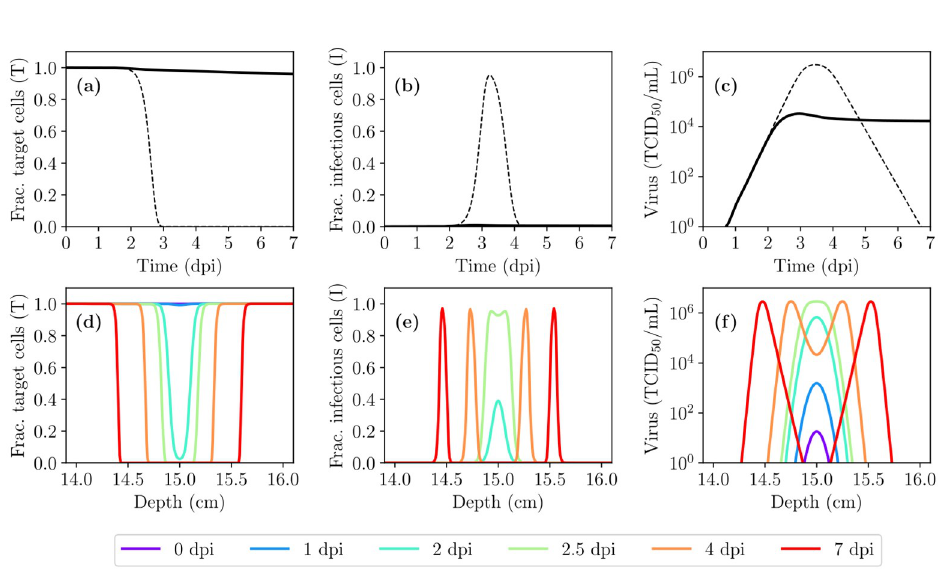
Fig 2. IAV infection kinetics in the presence of diffusion alone (no advection). (Top) Time course (averaged over space) of the infection for the fraction of cells in the (a) target/uninfected or (b) infectious state, and (c) the infectious virus concentration, obtained using the non-spatial ODE MM (dashed) or the spatial (diffusion only) MM (solid). (Bottom) Localized fraction of cells in the (d) target or (e) infectious state and (f) the infectious virus concentration as a function of depth within the HRT shown at specific days post-infection